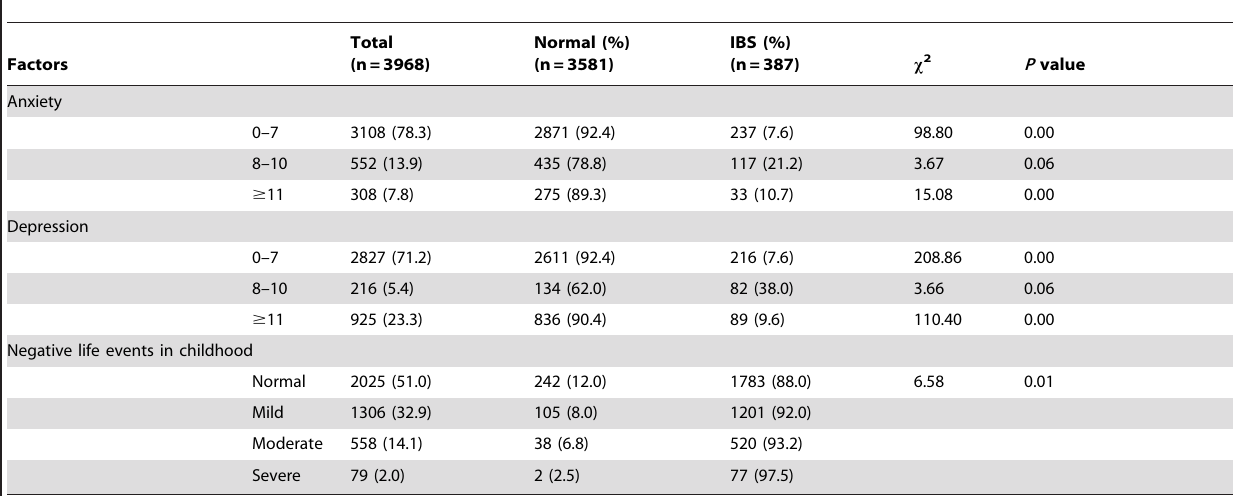
Table 4. Univariate analysis of psychological factors of irritable bowel syndrome and control groups.